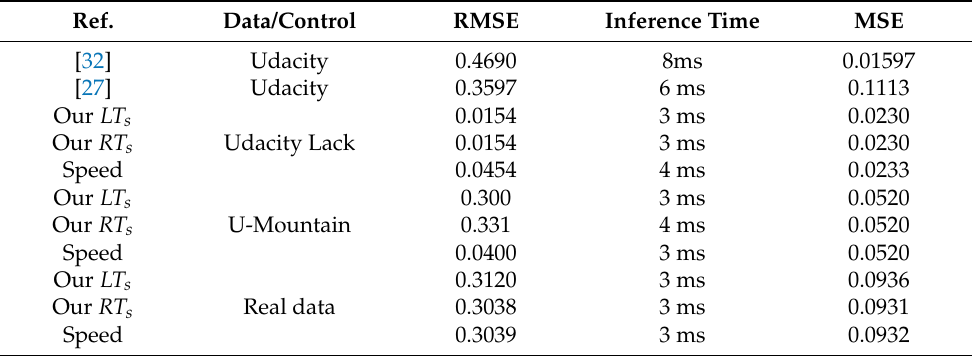
Table 6. Comparison of the proposed framework with existing frameworks in terms of data, RMSE, inference time, and MSE.